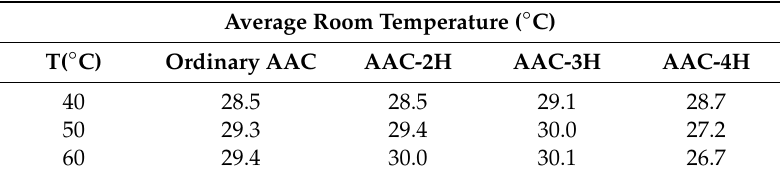
Table 4. Average room temperature of the AAC wall with different PCM conical holes.